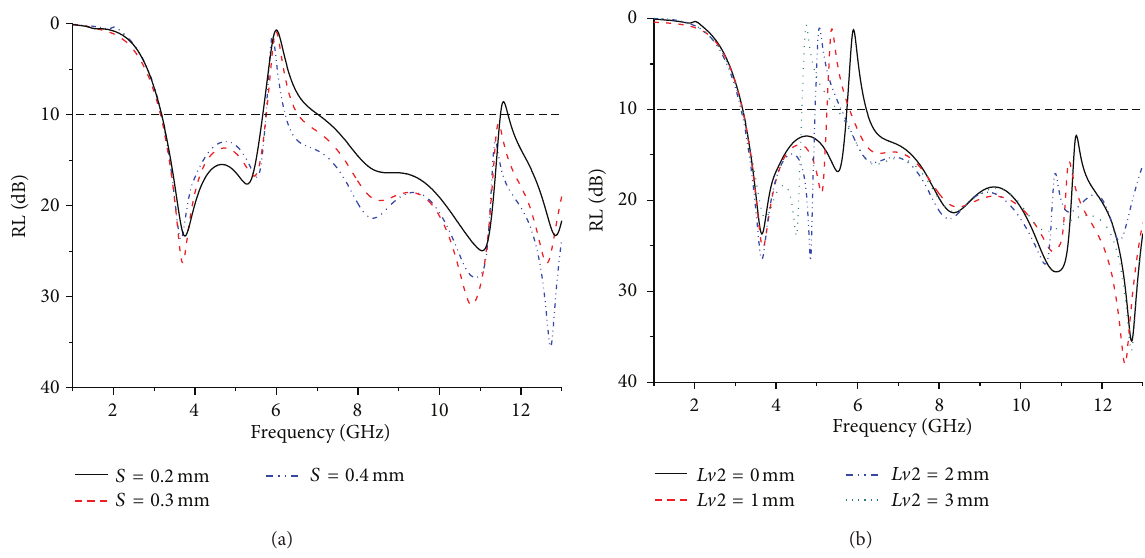
Figure 8: Band notch versus frequency (a) for different values of the parameter S (other parameters: Lv2 = 0mm, Ln = 4 mm, Lv1 = 0.2 mm, and Ws = 1mm) and (b) for different values of the parameter Lv2 (other parameters: S = 0.2 mm, Lv1 = 13.5 mm, Ln = 4mm, and Ws =